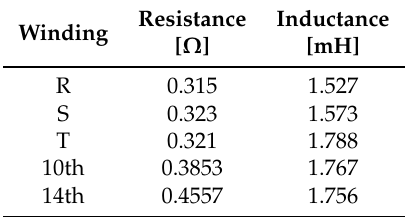
Table 5. Impedance windings measures.